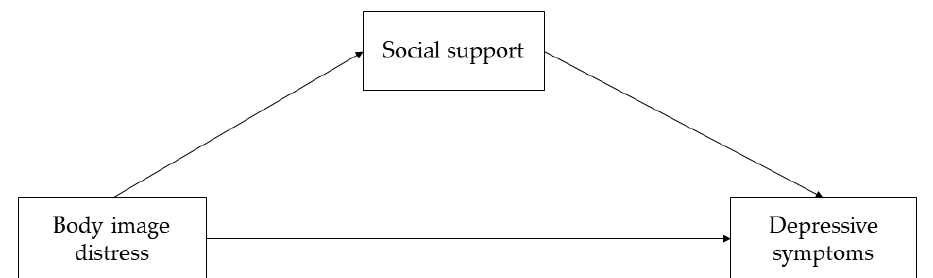
Figure 1. The hypothesized mediation model.